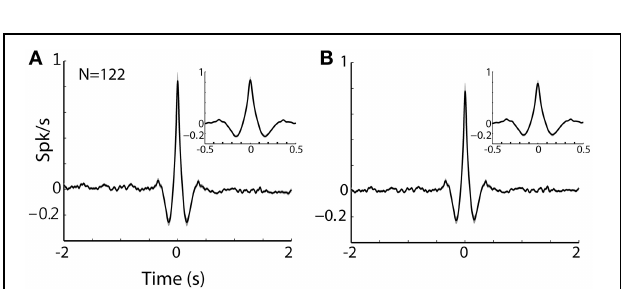
FIGURE 7 | MSN-interneuron pairs do not display narrow peaks or troughs in their cross correlation histograms. (A) Raw (with no normalization) cross correlation histograms (CCH) between pairs of striatal interneurons and MSNs averaged over all pairs. Black line and gray shaded envelope display average and SEM values, respectively. Cross correlation histograms were computed with 1ms bins for ± 100ms around the trigger spike and were smoothed using a Gaussian ( SD of 2ms). The MSN (trigger cell) discharge is at time zero. Ordinate: conditional firing rate (spikes/s) of the FSI and TAN (reference cell), given a spike of the MSN at time zero. Abscissa: Time lag (in ms) around the discharge of the trigger cell. Axis labels on lower left subplots apply for all subplots. (B) Normalized CCH (using the PSTH predictor) averaged over behavioral events for all interneurons to MSN pairs.